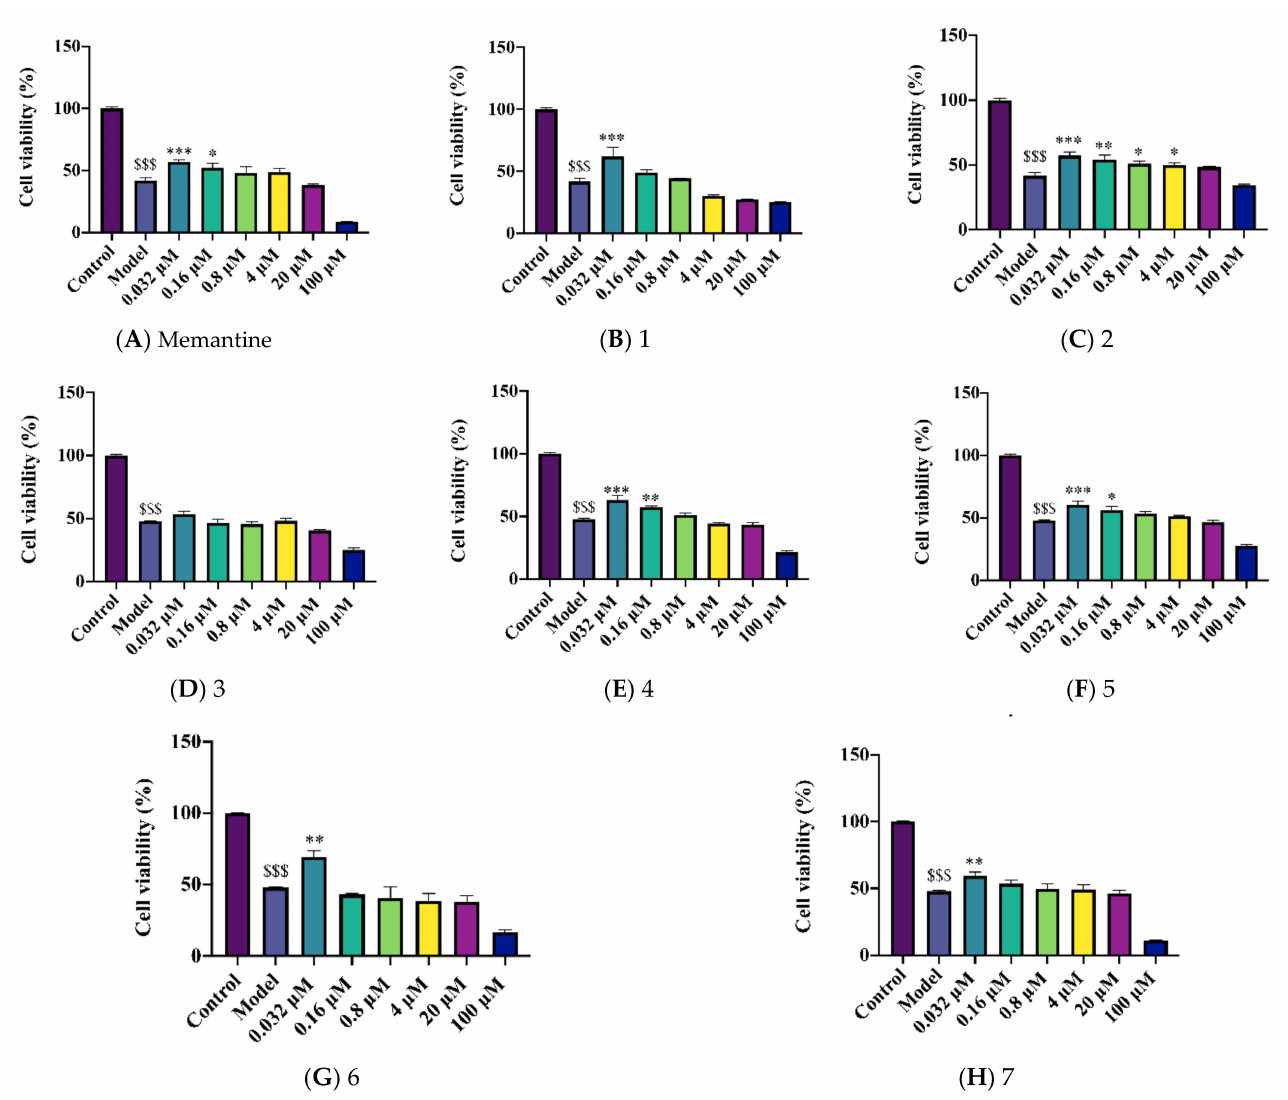
Figure 5. Cell viability of novel structural derivatives of memantine in glutamate-injured SH-SY5Y cells. ( A – H ) Cell viability of memantine (as a positive drug) ( A ) and memantine derivatives, in- cluding 1 ( B ) modafinil-memantine, 2 ( C ) piracetam-memantine, 3 ( D ) picamilon-memantine, 4 ( E ) glycyl-glycine-memantine, 5 ( F ) glycyl-glycyl-glycine-memantine, 6 ( G ) sarcosine-memantine, 7 ( H ) dimethylglycine-memantine, using MTS assay. Data are expressed as mean ± SEM, n = 3. $$$ p < 0.001 vs. the control group; * p < 0.05, ** p < 0.01, *** p < 0.001 vs. the